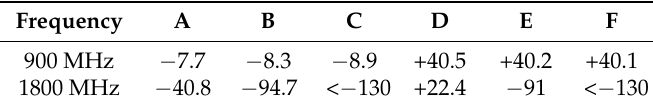
Table 2. Measured link-budget for the harmonic distortion measurement system, in dBm, at different locations marked in Figure 8. Frequency